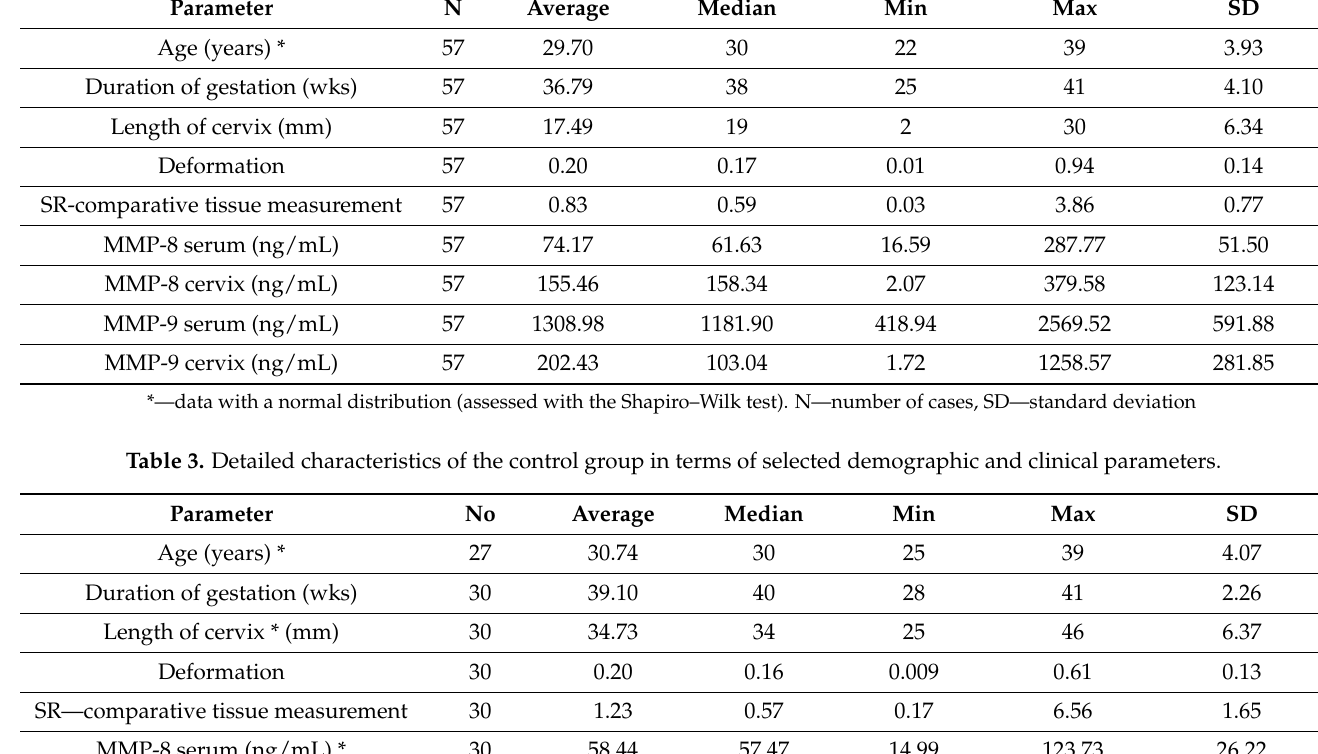
Deformation SR—comparative tissue